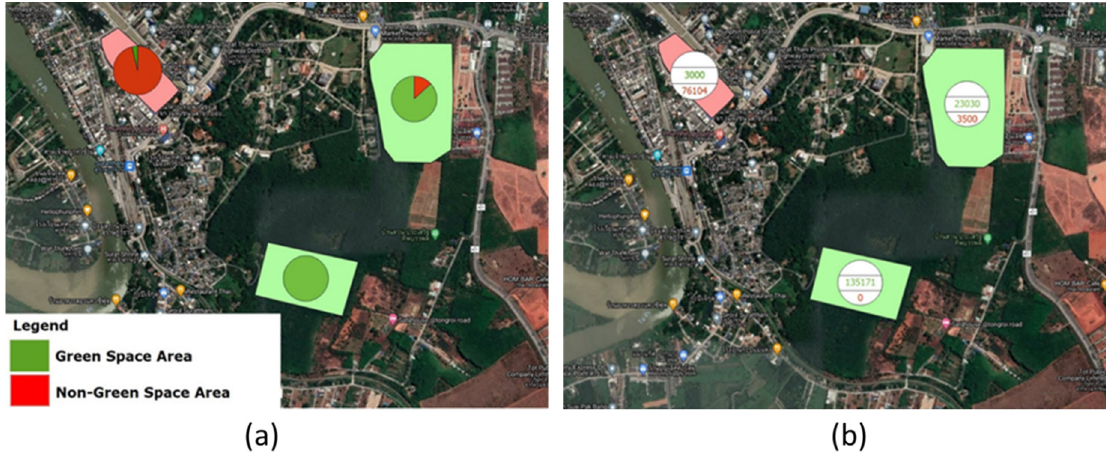
Figure 11. Augmented map reports on green space areas using a pie chart ( a ) and numeric diagram ( b ).